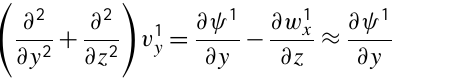
Fig. 2. Thick solid lines show the allowable domain k solid lines are solutions of Eq.